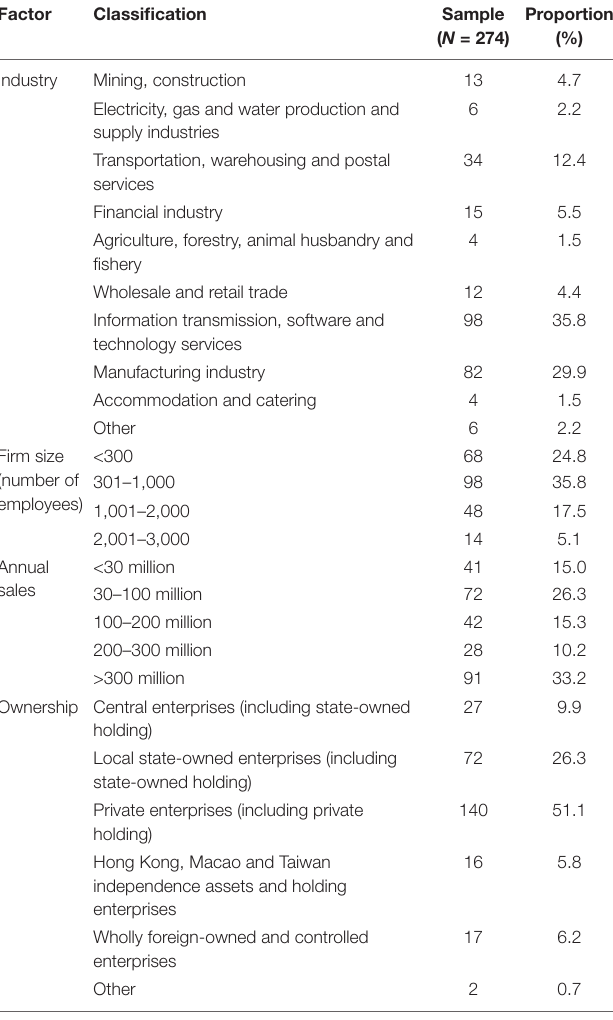
TABLE 1 | Descriptive statistics of the sample and